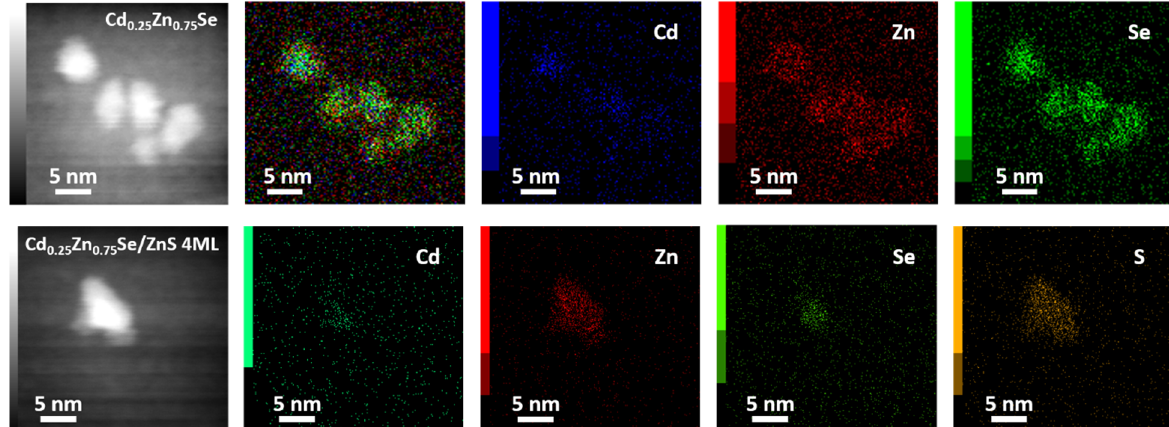
Figure 5. HAADF-STEM image and corresponding EDS elemental mapping of Cd, Zn, S, and Se of Cd 0.25 Zn 0.75 Se/ZnS core/shell QDs.